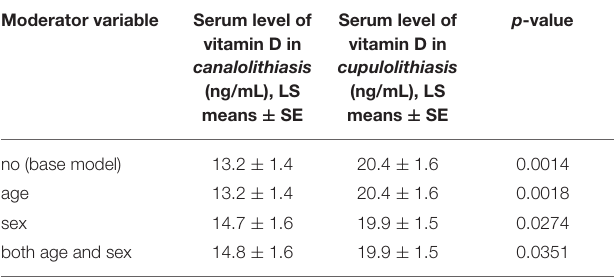
TABLE 2 | Serum level of vitamin D in patients with canalolithiasis and cupulolithiasis, and the covariates used in the general linear model. Moderator